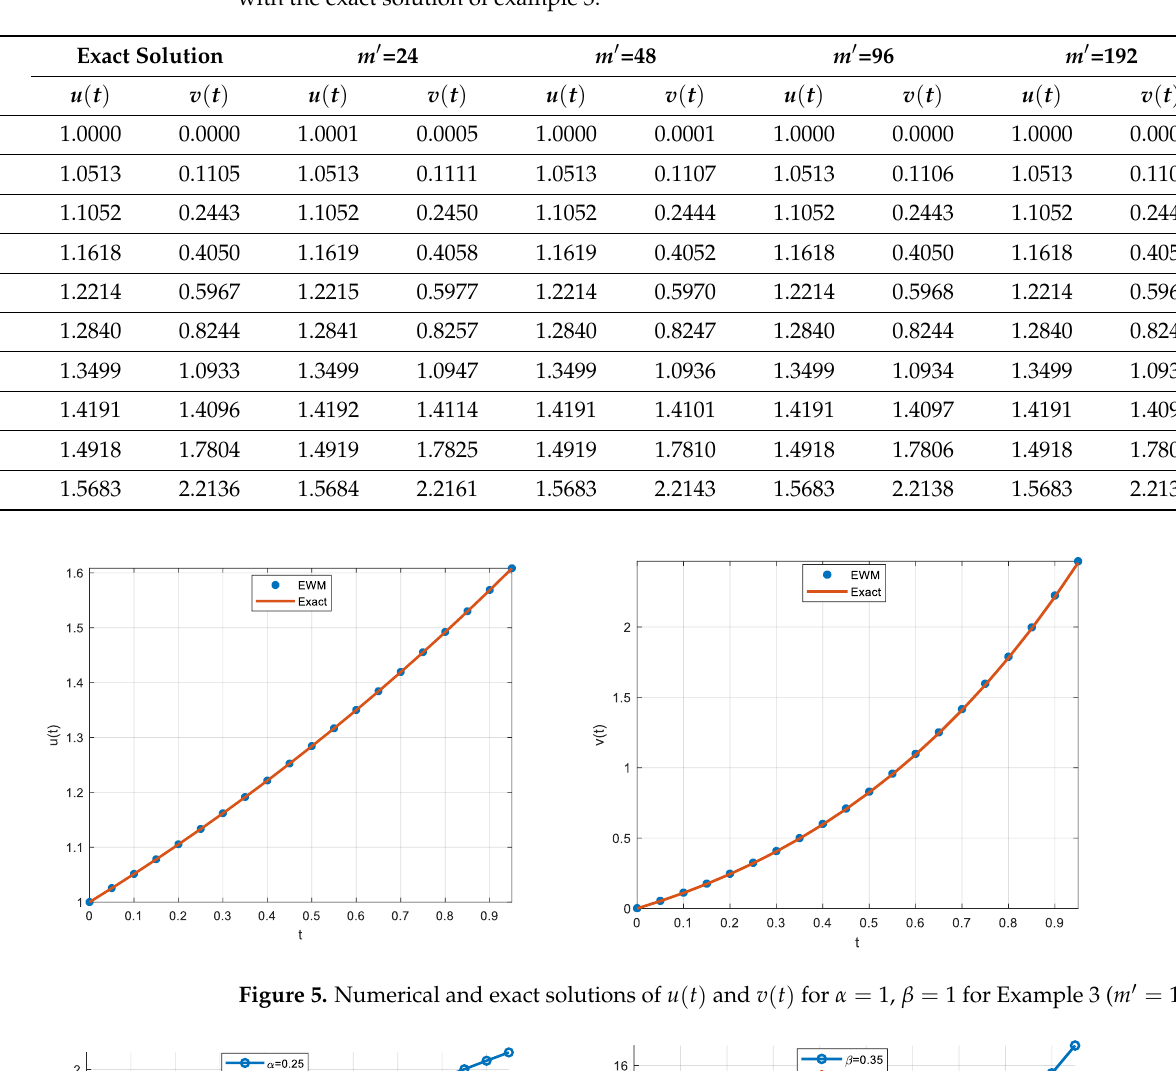
Table 3. Output values u ( t ) and v ( t ) of the proposed method for α = 1, β = 1 and several m (cid:48) values with the exact solution of example 3.